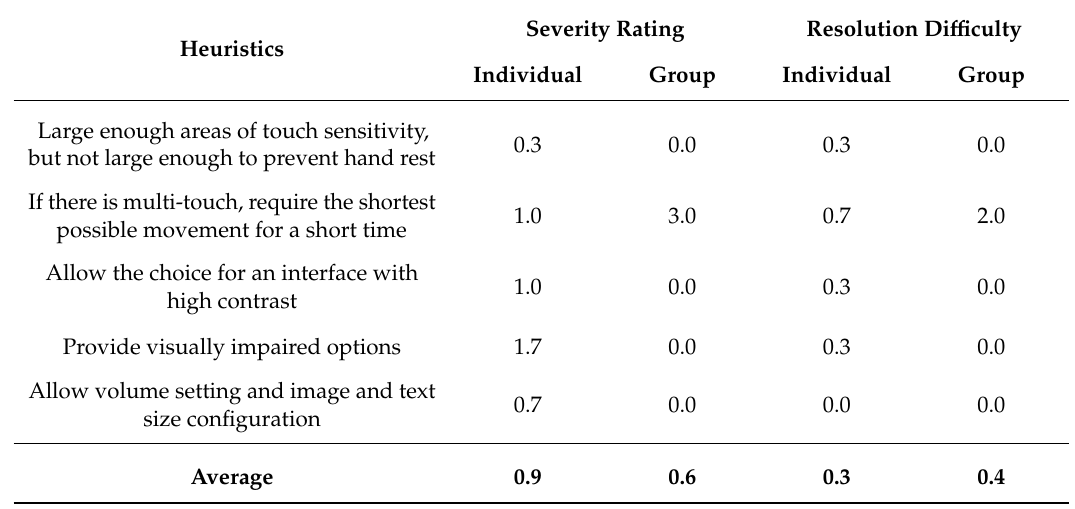
Table 10. Heuristics analysis of the game’s accessibility [38].